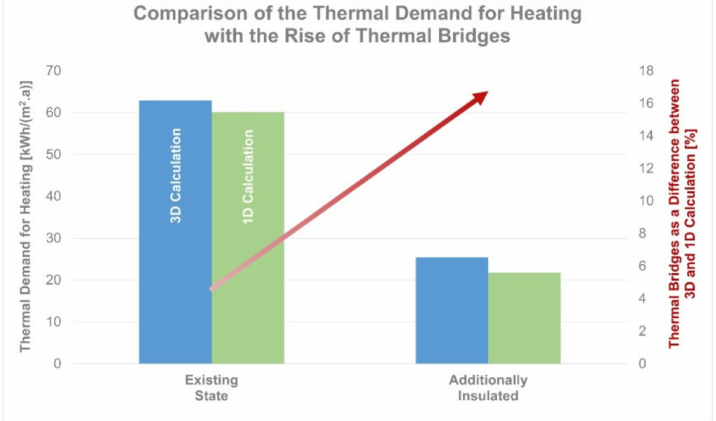
Figure 1. Comparison of heating demand with the increase in thermal bridges (Adapted from Ref. [2]). The proportion of thermal bridges is defined as the difference between 3D and 1D calculation of the heating demand. The calculations were performed for the existing, non-insulated facade and retrofitted (i.e., additionally insulated facade of an apartment